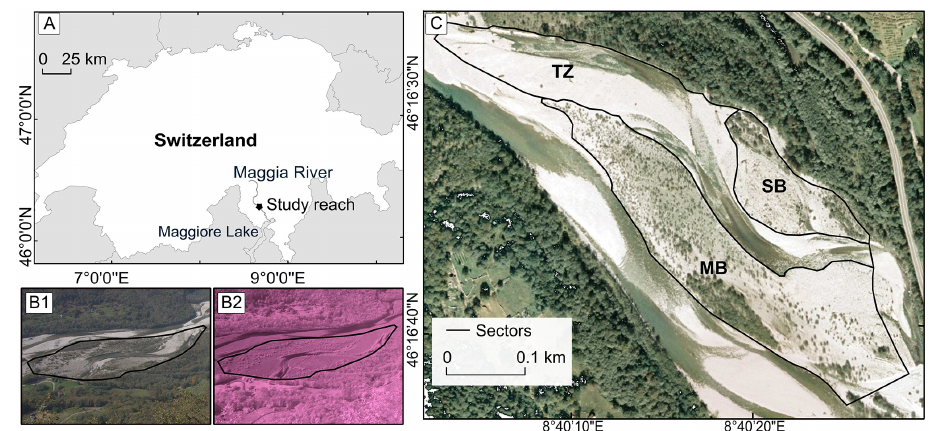
Figure 1. (a) Study reach location within Switzerland. (b) Maggia Valley view from the cameras (VIS left, and IR right). (c) Study reach subdivided into three units: main alluvial bar (MB), secondary alluvial bar (SB), transitional zone (TZ); flow is from top left to bottom right.